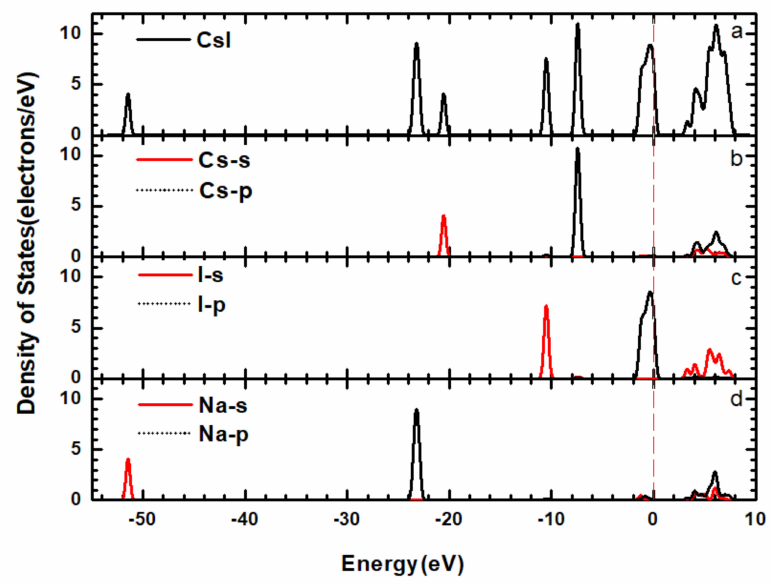
Figure 9. (Color online) TDOS ( a )and PDOS ( b – d ) of the CsI(Na) (010) surface without H 2 O molecule